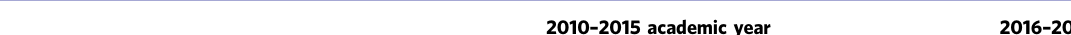
Table 1 Descriptive statistics of students between 2010 and 2107.